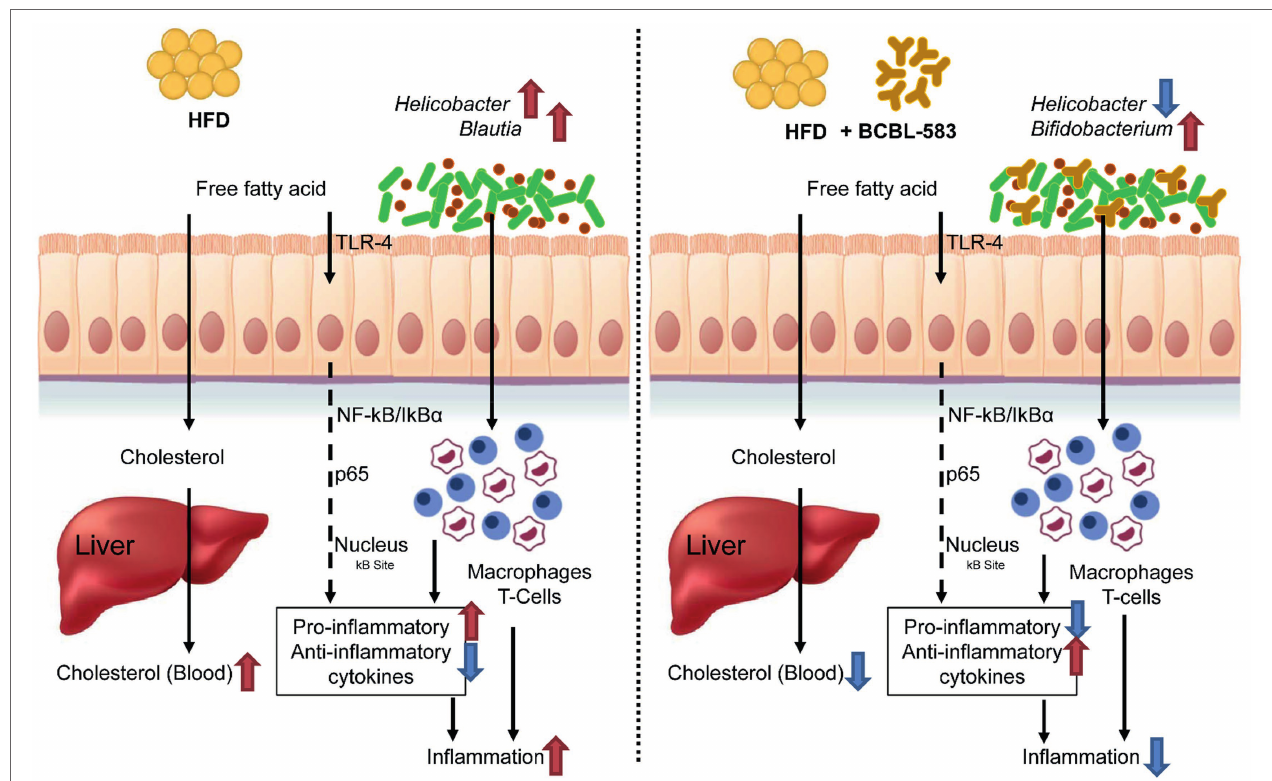
FIGURE 8 | Summary on the probiotic effect of B. longum BCBL-583 in HFD mouse